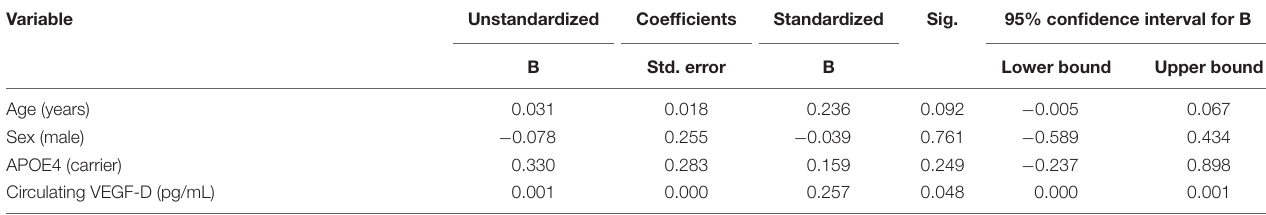
TABLE 4 | Association between VEGF-D and small vessel